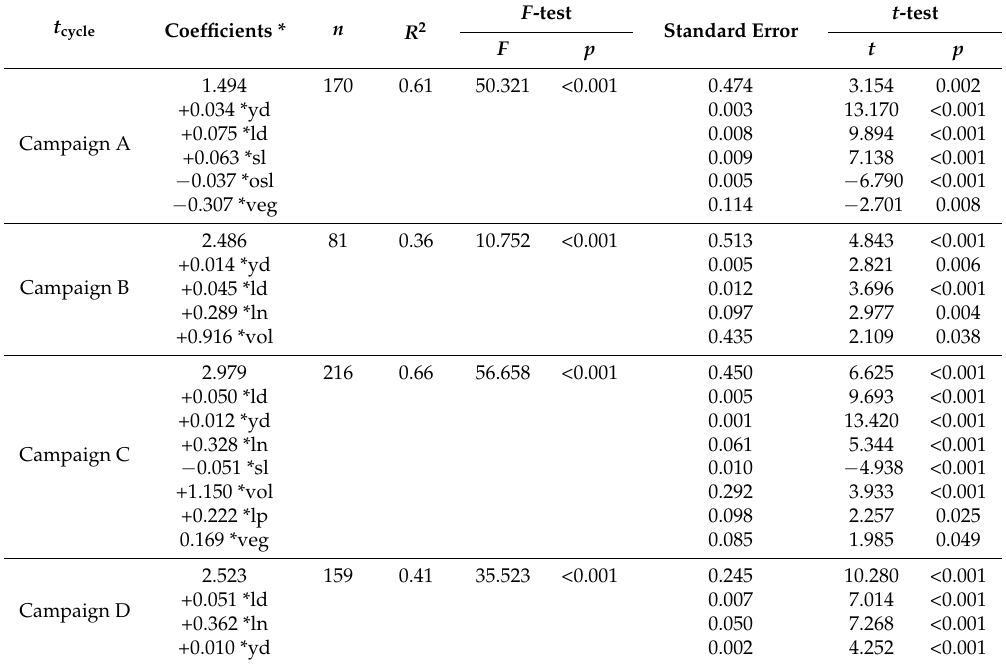
Table 5. Stepwise Multiple Regression Models and Test Statistics for the Cycle Times ( t cycle ) of the Four Data Collection Campaigns Based on Qualified Observations ( n